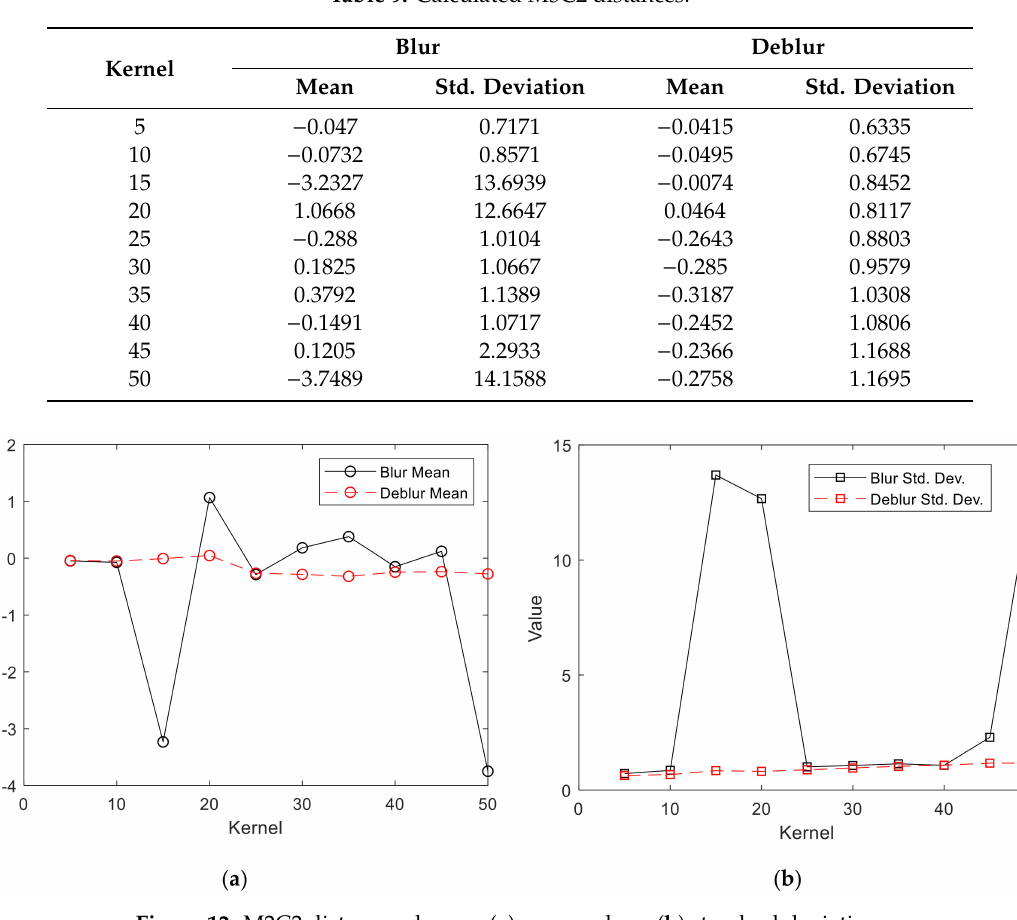
Figure 12. M2C2 distances change: ( a ) mean values; ( b ) standard